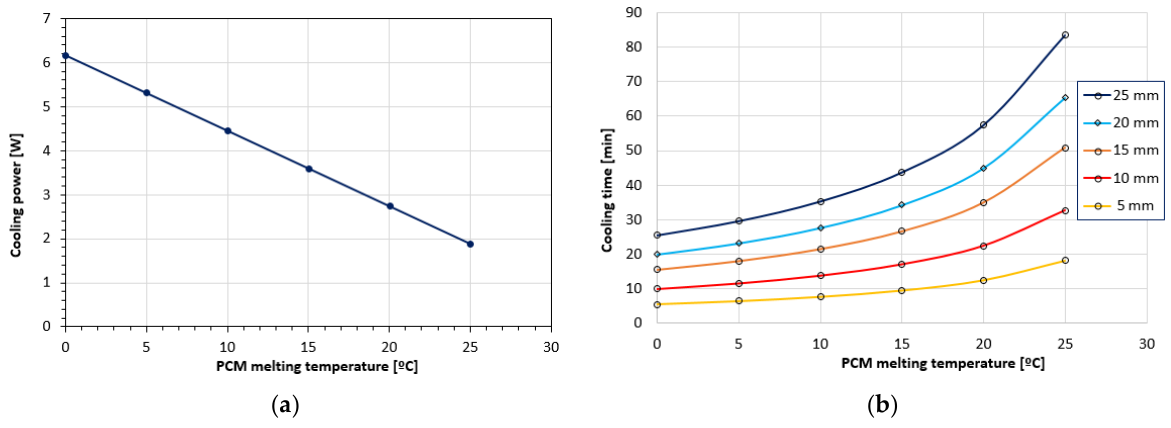
Figure 7. Results of parametric study: ( a ) Cooling power plateau values, Equation (18); ( b ) Cooling time, Equation (22). The numbers in the legend indicate the PCM thickness in mm.